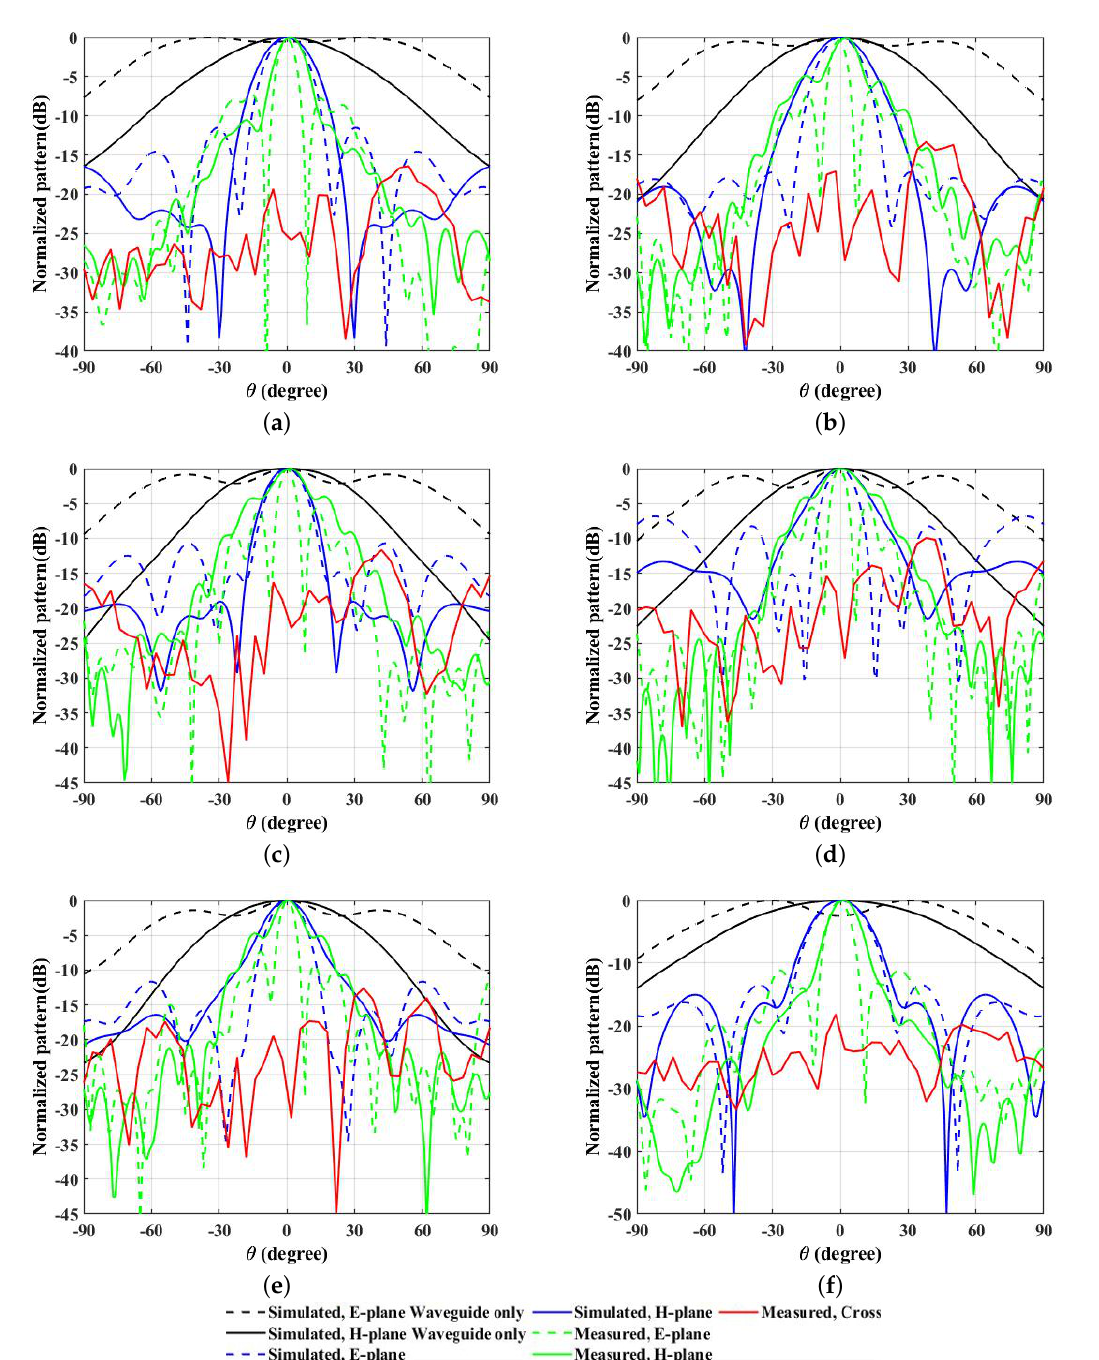
Figure 11. Simulated and measured radiation patterns as observed with the use of the copper-painted ABS designed surface, which is shown in ( a – f ) for 10 GHz, 11, GHz, 12 GHz, 13 GHz, 14 GHz, and 15 GHz